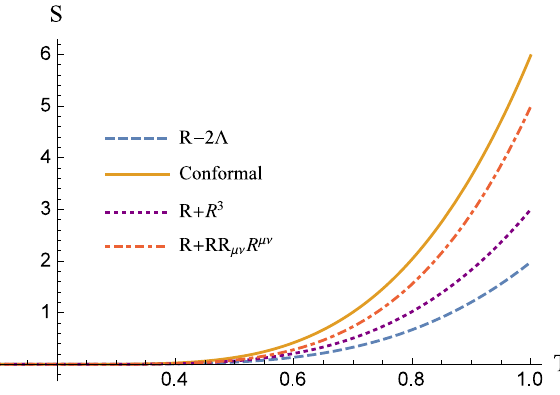
Fig. 2 One-loop correction to the entropy in four special cases of f ( R , R μν R μν ) . We have assumed (cid:10) = −